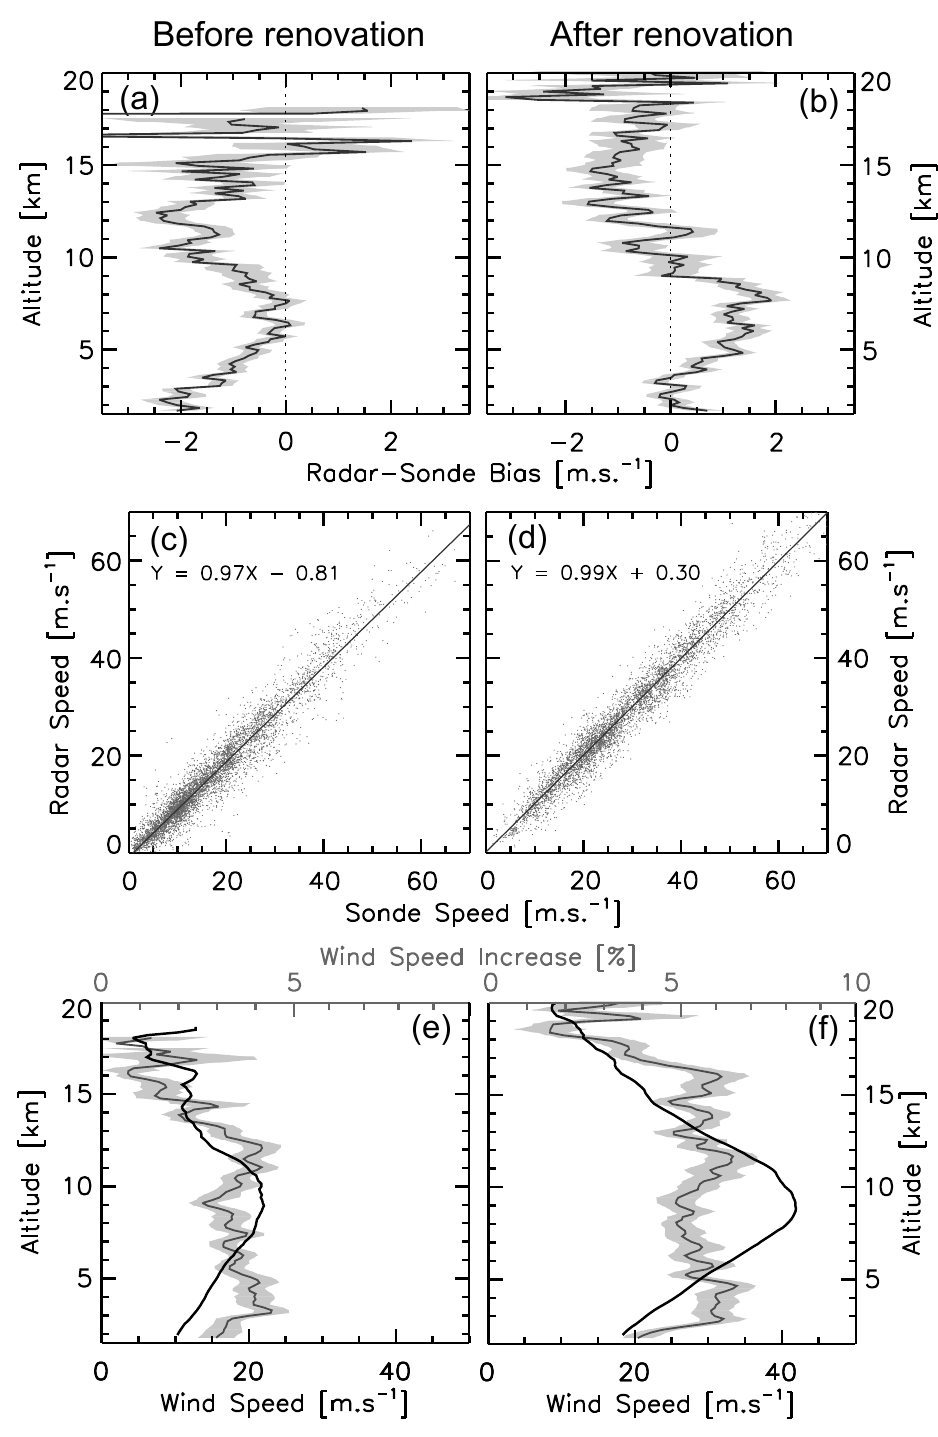
Figure 1. Comparison of wind speeds measured by the MST radar, and 75 and 52 radiosonde launched from the Aberystwyth radar site, pre- and post-renovation, respectively. (a) Average radar–radiosonde wind speed differences at different altitudes, before the renovation. Negative differences correspond to radar speeds smaller than radiosonde speeds. The grey shading shows the standard error. Radar winds have been corrected for aspect sensitivity. (b) As (a) but after the renovation. (c) MST against radiosonde wind speeds at all altitudes. The grey line is a best fit, quantified by the text at the top of the panel. (d) As (c) but after renovation. (e) Average MST radar wind speed (bottom axis and black line) and aspect sensitivity correction (top axis and grey line, with shading giving standard error) for the pre-renovation comparison. (f) As (e) but after